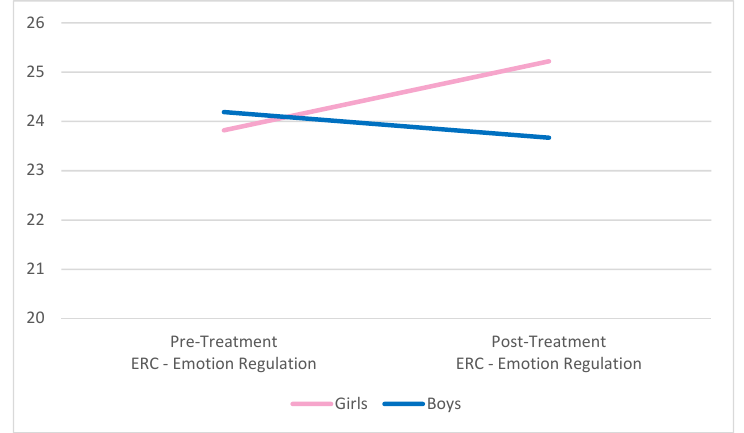
Figure 2. Pre- and post-treatment overall emotion regulation by gender. Notes. No significant differences comparing pre-/post-treatment or comparing boys to girls. ERC = Emotion Regulation Checklist.